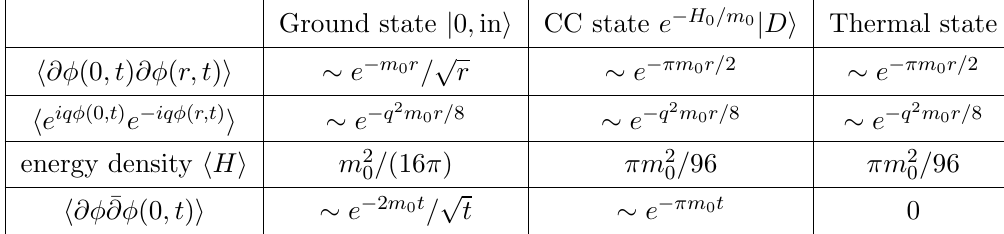
The 2nd and 3rd columns give equal time correlators at late times for a mass quench (2.34) ; the 4th column gives the same correlator (time-independent) in a thermal state with (cid:12) = 4 =m 0 . In the 2nd-column the initial state is the ground state j 0 ; in i ; in the 3rd column, the initial state is a special squeezed state (2.58) which is of the Calabrese-Cardy form e (cid:0) H=m 0 j D i . In the (cid:12)rst two rows, we list two-point functions at separated points. In the 3rd row we list the asymptotic energy density. In the 4th row, we list the late time behaviour of a one-point function; the vanishing asymptotic value agrees with the thermal state | but we compare here the exponen- tial decay in time between the second and third columns. Note that the asymptotic values always agree between the CC state and the thermal state, but barring the case of the exponential vertex operator, the late time behaviour di(cid:11)ers from the CC state, signifying non-trivial modi(cid:12)cation of the behaviour by the higher chemical